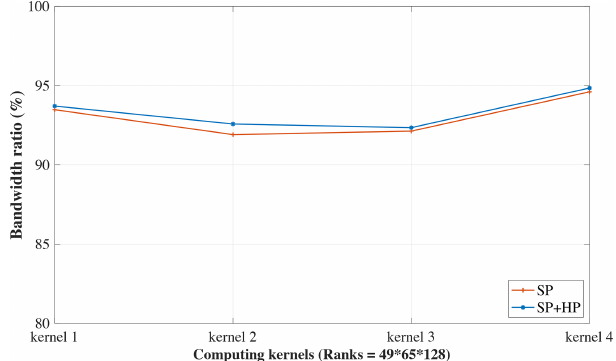
Figure 11. Bandwidth ratio of the tracer_fct process.